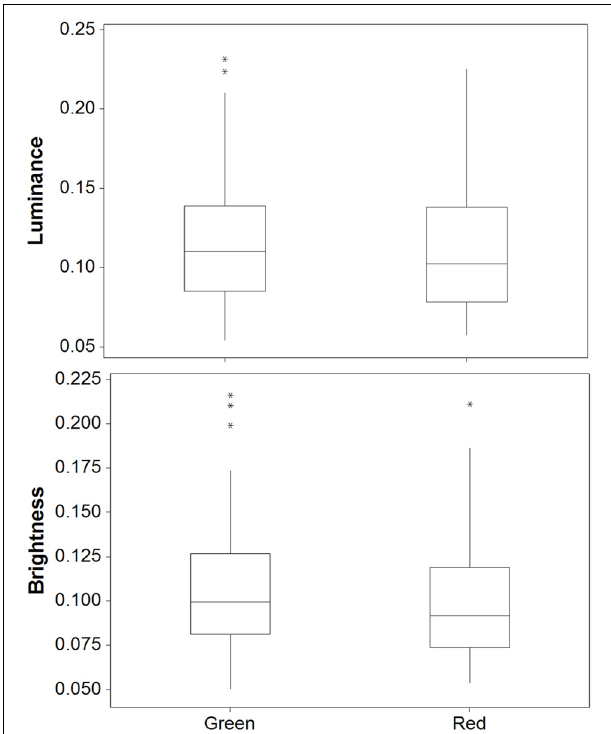
FIGURE 9 | Luminance (top) and brightness (bottom) values for crabs in experiment 2 on red and green backgrounds [main boxes show medians plus inter-quartile range (IQR), whiskers are lowest and highest values that are within 1.5 ∗ IQR from the upper and lower quartiles, asterisks represent